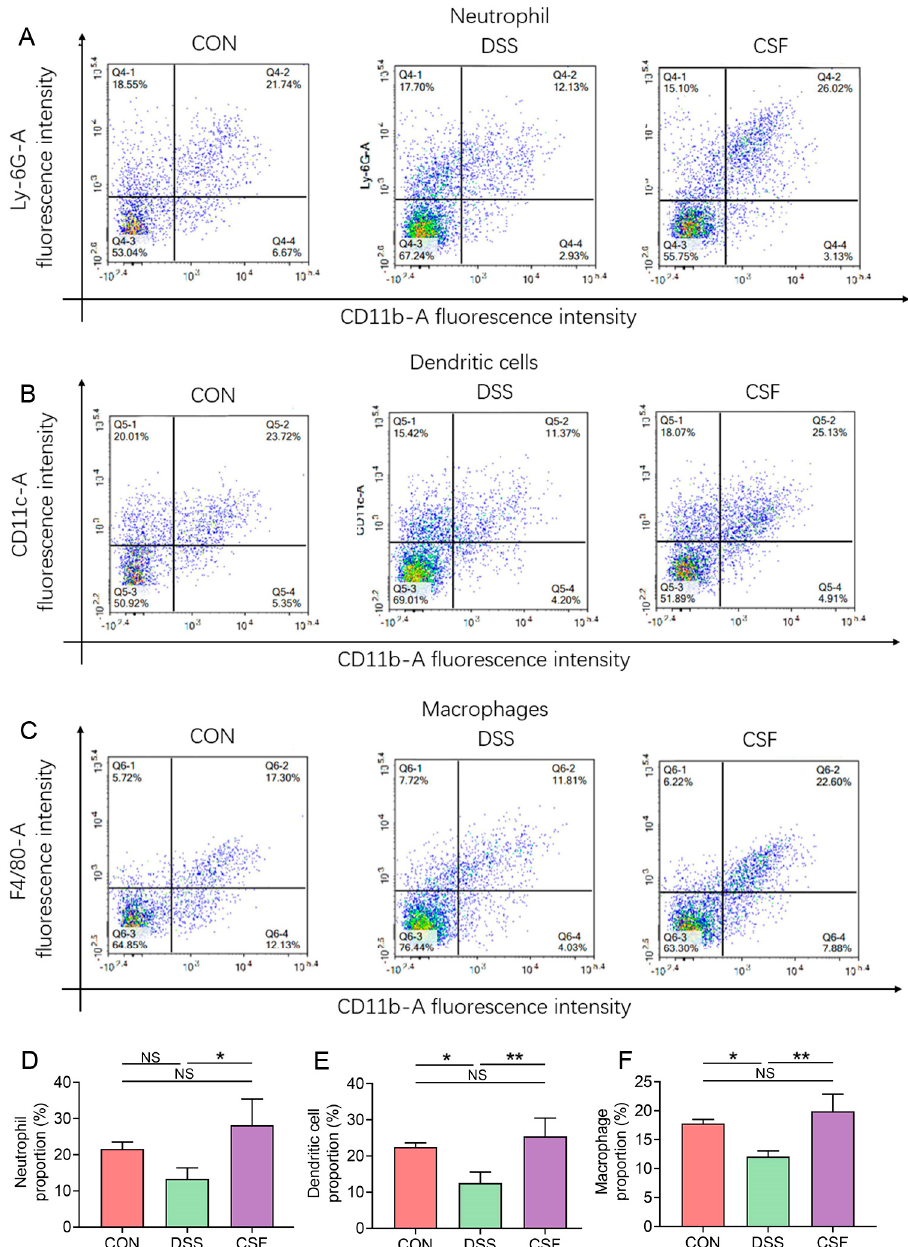
Figure 7. CSF changed the innate immune cell proportion in the colon of the colitis mice ( n = 5). ( A – C ) Results for the abundance of neutrophils, dendritic cells, and macrophages in each group. ( D – F ) The bar graph of the three results. The data are presented as mean ± SD, * p < 0.05, ** p < 0.01.